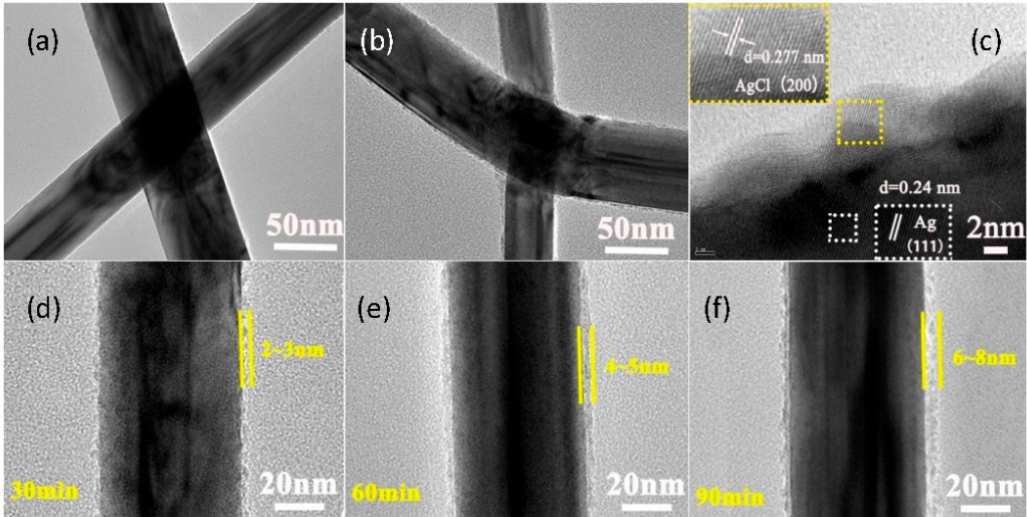
Figure 1. ( a ) TEM image of pristine 50 nm-thick silver nanowires (AgNWs). ( b ) TEM and ( c ) high resolution (HR)TEM images of FeCl 3 dilute solution (DS) treated 50 nm-thick AgNWs. The inset is the local magnified image of outer AgCl crystals. TEM images of AgNWs treated by FeCl 3 -DS for ( d ) 30 min, ( e ) 60 min, and ( f ) 90 min.